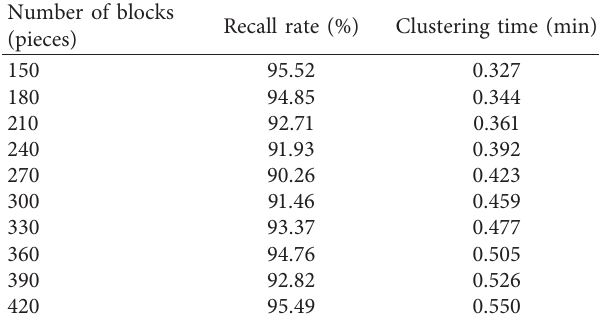
Table 2: Results of image redundancy processing in Method